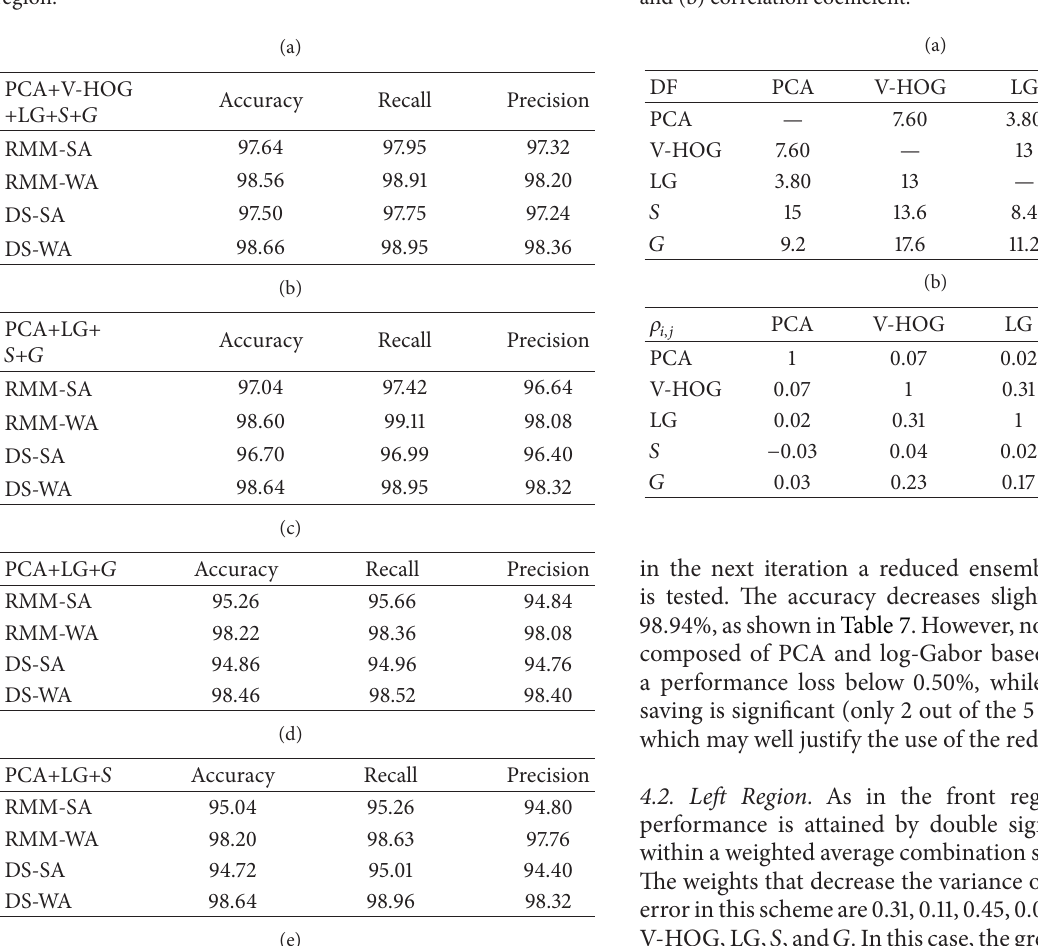
Table 11: Performance of the proposed ensembles for the right region.